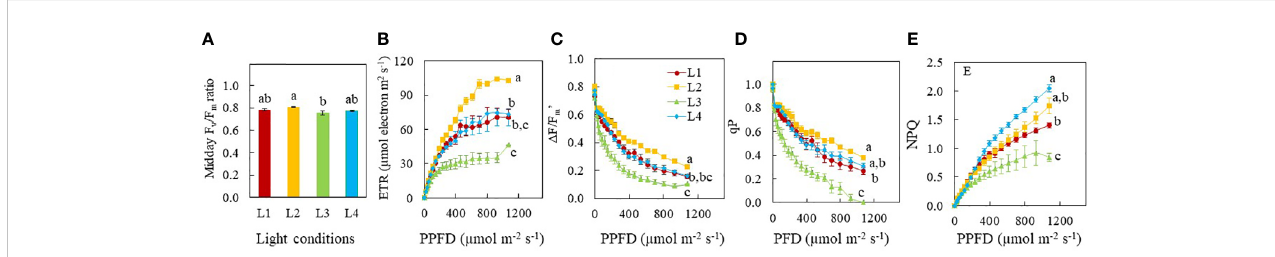
FIGURE 6 F v /F m ratio (A) of Purslane (n=8) grown under different light treatments for 9 days. Light response curves of ETR (B) , D F/F m ’ (C) , qP (D) and NPQ (E) of purslane (n=5) grown under different light conditions for 12 days. Values are means ± standard errors. Means with different letters are statistically different ( p <0.05) as determined by Tukey ’ s multiple comparison test. Refer to Figure 1 for the different conditions of L1, L2, L3 and